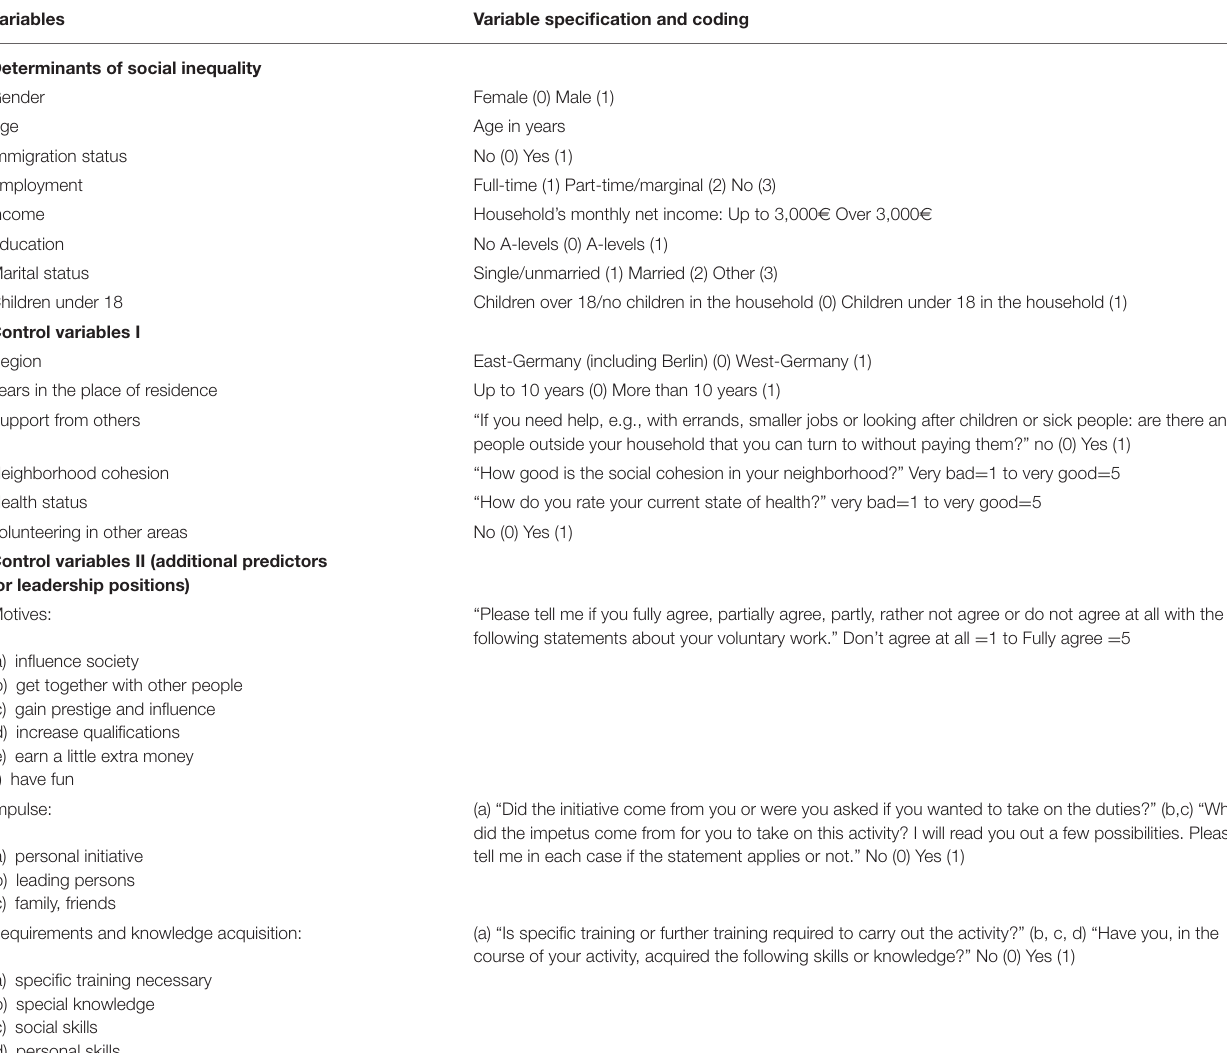
TABLE 1 | Independent variables—variable